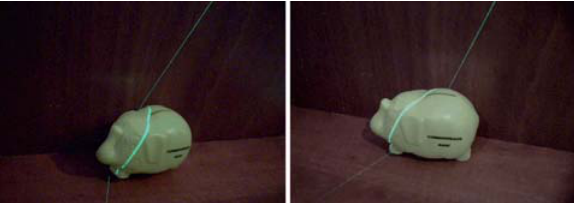
Figure 1. A typical stereo pair used in the scanning process. Homologue points are found as intersections of the laser profile with (epipolar) image lines, which represents a peak detection task. Several peak detection approaches are found in literature (Fisher & Naidu, 1996). Here, a Gaussian curve is fitted directly to the intensity values of each row. To relax the strictness of 1D interpolation, two further Gaussian curves with common peak position are simultaneously adapted in the directions of the two main diagonals through the initial peak estimation. In this